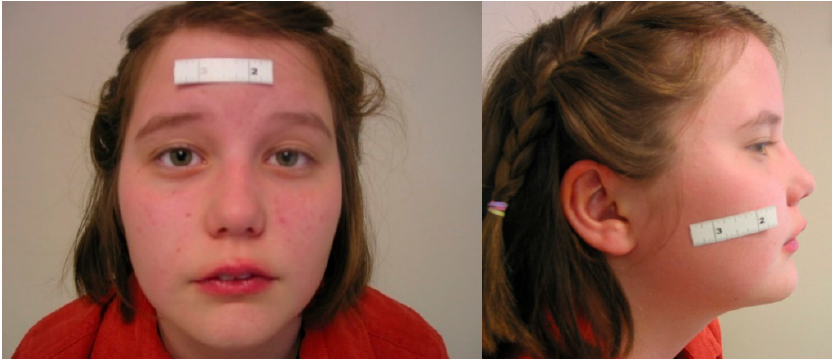
Figure 1. Clinical features of the proband with complex ASD involving epilepsy and strabismus. The photograph depicts the patient aged 13 years old. There are no dysmorphic features aside from subtle right-sided facial prominence. Her strabismus was corrected with glasses (not shown), and eventually was surgically corrected by age 24.